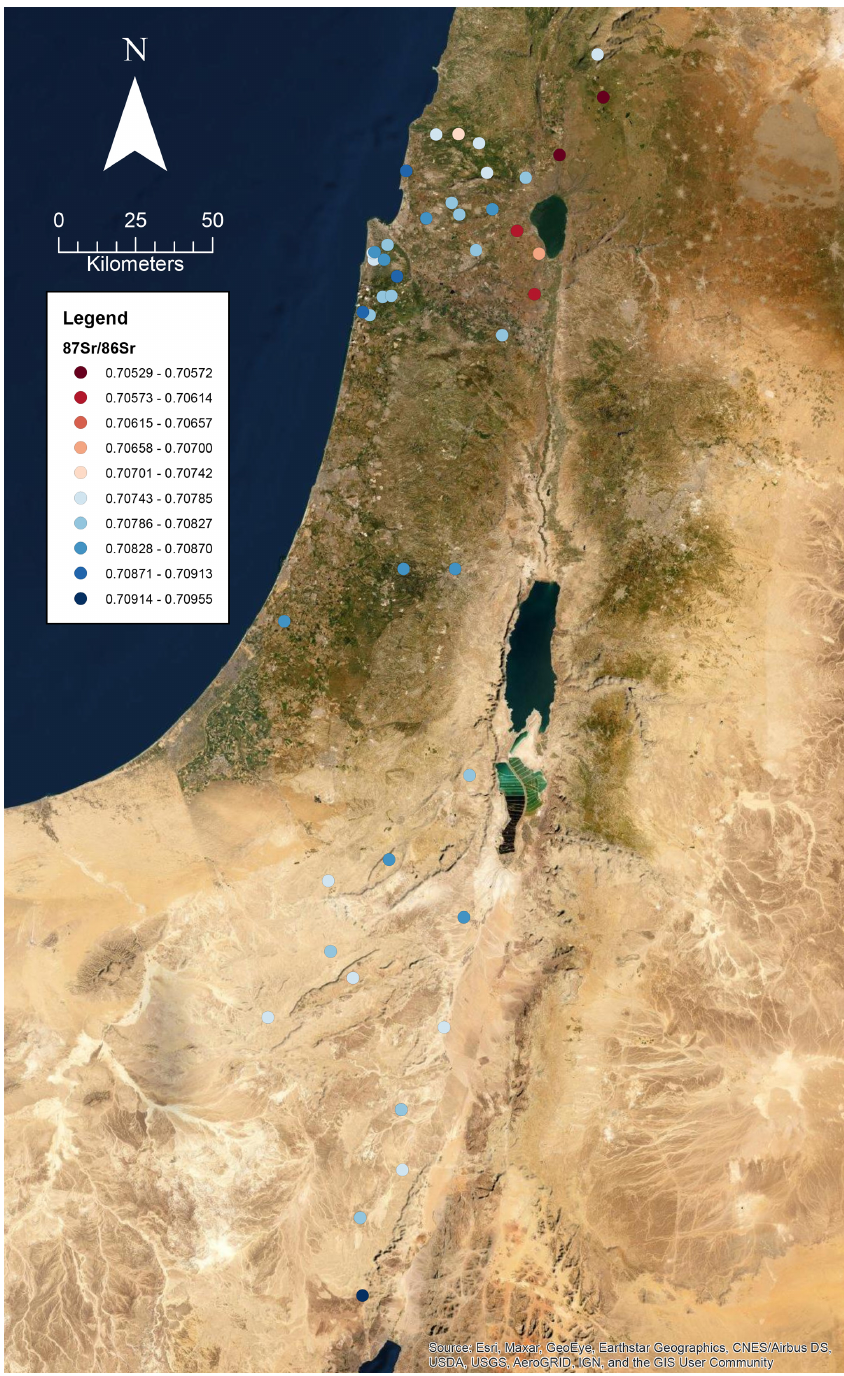
Figure 2. Bioavailable 87 Sr / 86 Sr of rock samples, excluding samples with high 87 Sr / 86 Sr